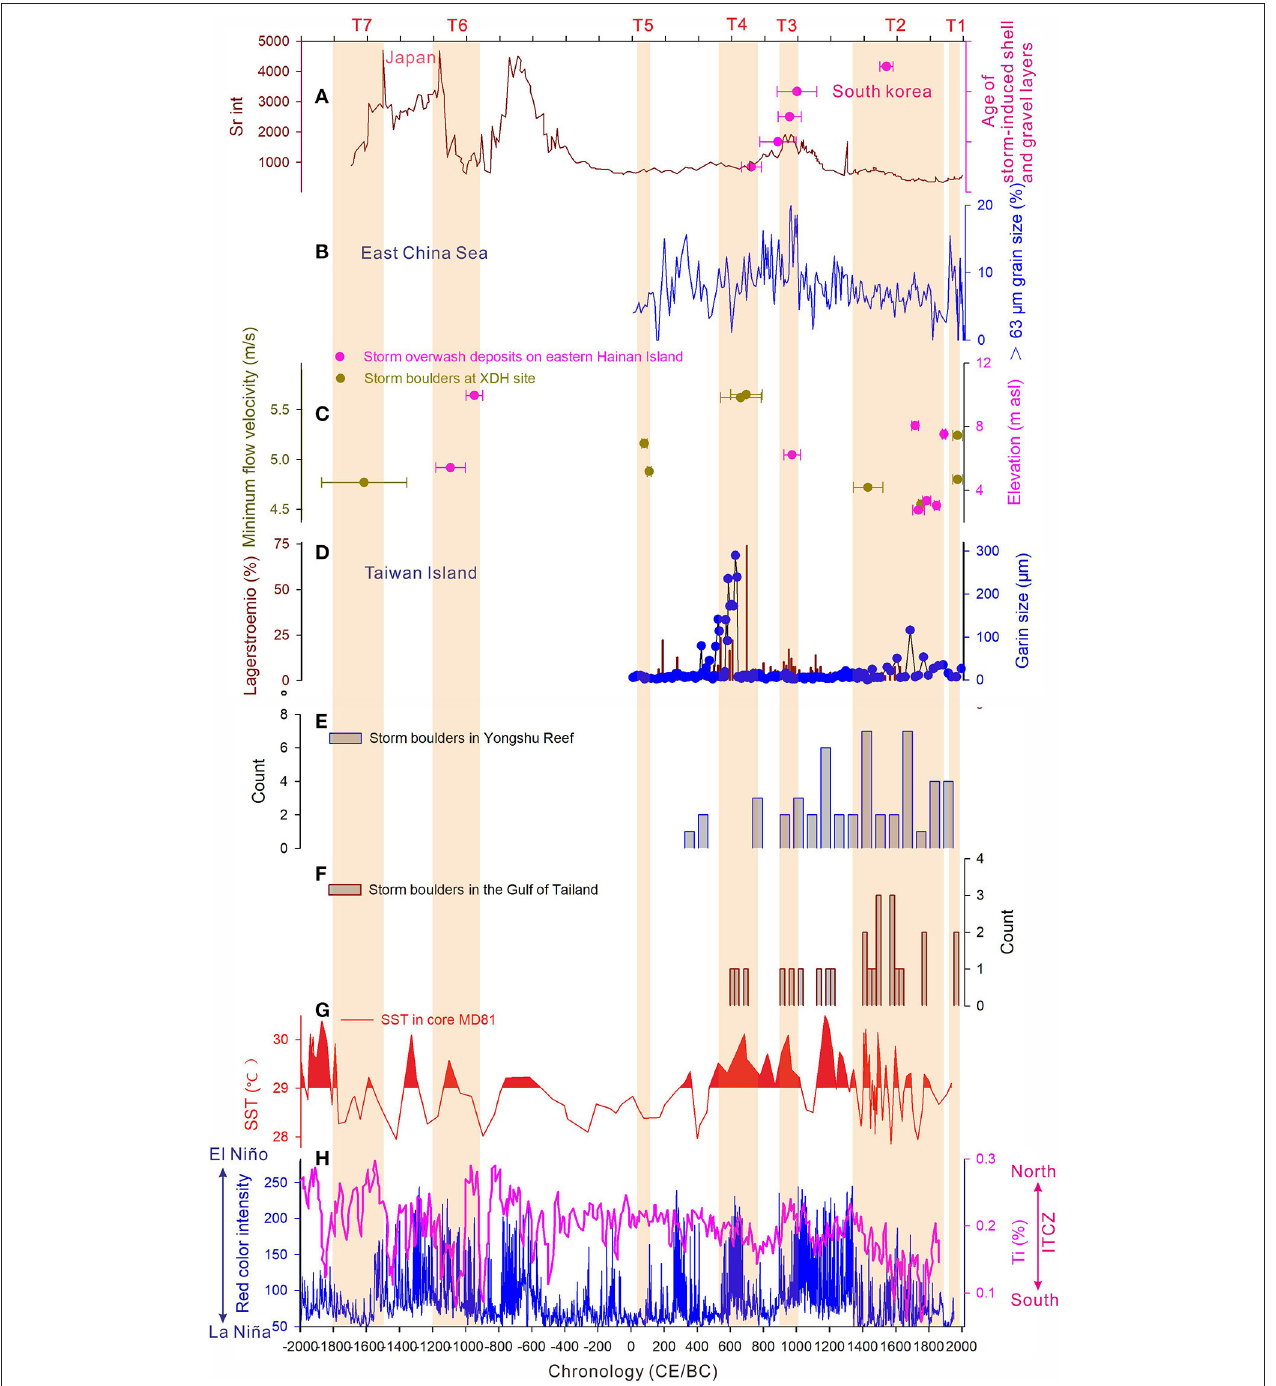
FIGURE 7 | Comparison of the large typhoon periods on Hainan Island with regional paleo-typhoon reconstructions from the SCS and WNP. (A) The paleo-typhoon reconstructions from the Kamikoshiki Island, Japan (Woodruff et al., 2009) and large typhoon induced shell layers deposits (Yang et al., 2017); (B) typhoon-induced coarse grain deposits from East China Sea ( Zhou X. et al., 2019); (C) large typhoon periods in the Hainan Island (this study; Zhou et al., 2019b); (D) sedimentary records of large typhoon-induced extreme rainfall events from Taiwan Island (Chen et al., 2012); (E) Storm boulder deposits from Yongshu Reef, SCS (E) and Tailand (F) ; (G) SST reconstruction from core MD-81 (Stott et al., 2004); (H) El-Niño frequency reconstruction from Laguna Pallcacocha, Ecuador (Moy et al., 2002) and ITCZ reconstruction from anoxic Cariaco Basin (Haug et al., 2001). The brown bars representing large typhoon periods.